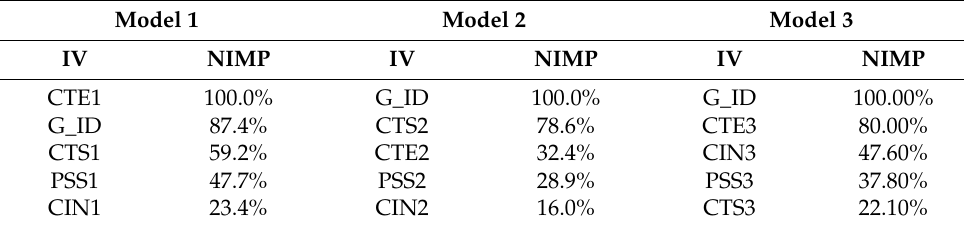
Table 4. The normalised importance of independent variables in three models, by T1, T2, and T3 time